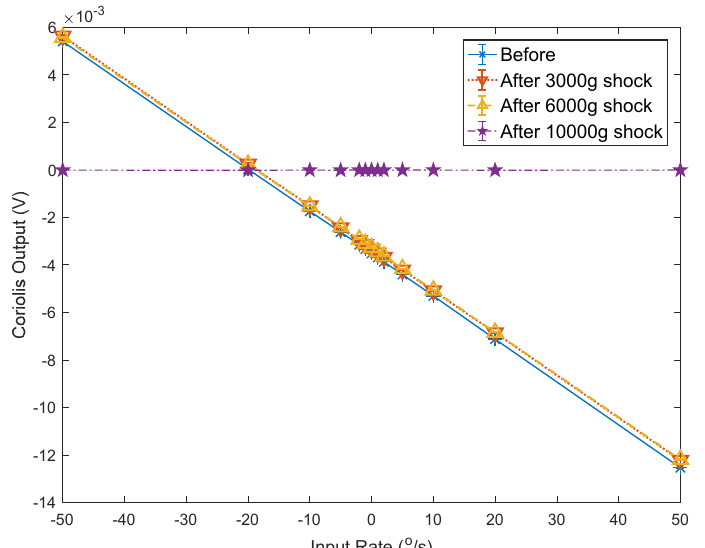
Figure 13. The experimental curves of scale fact before and after the impacts.